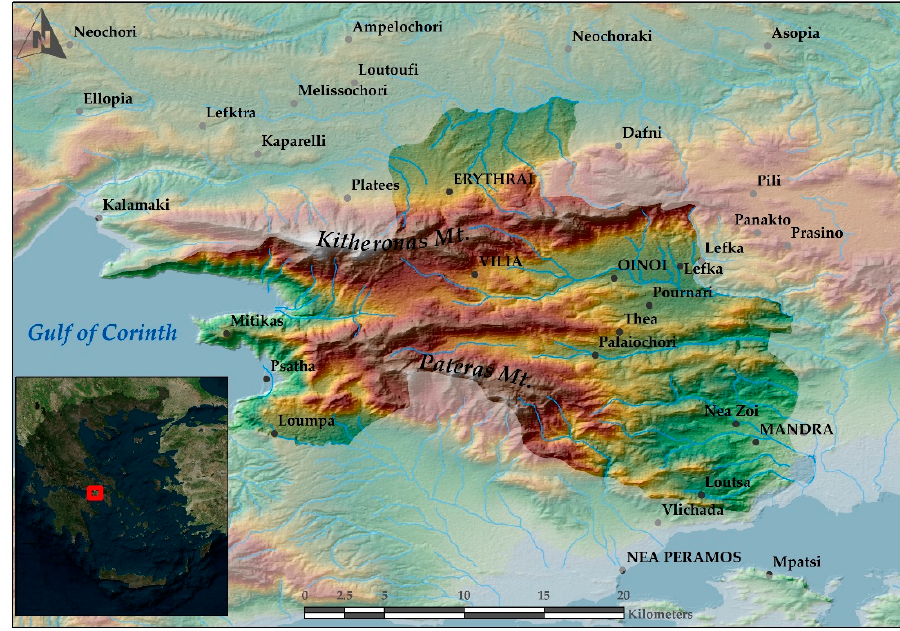
Figure 1. The study area.